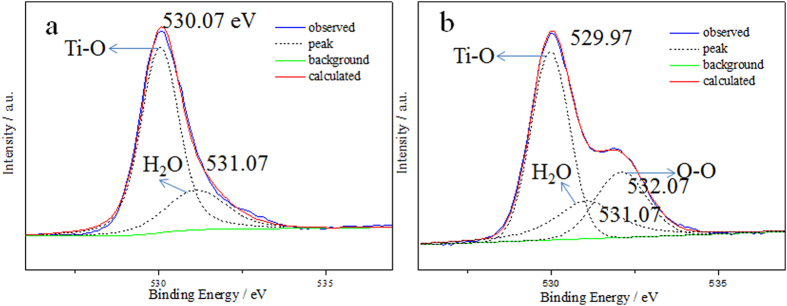
XPS spectra of O1s for (a) the HTO crystal and (b) the H2O2 treated HTO crystal.